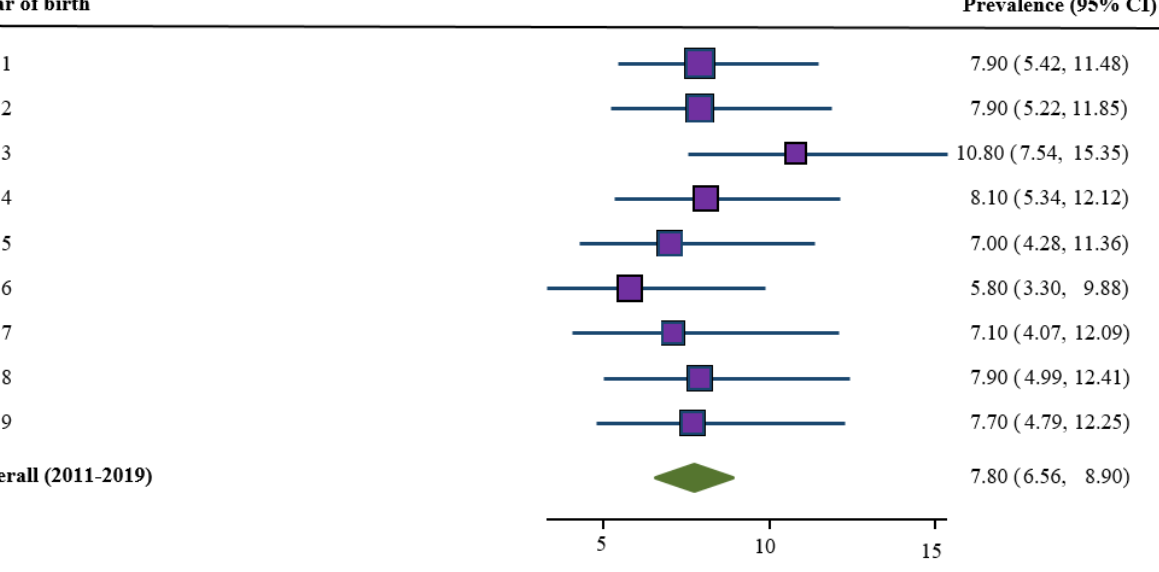
Figure 2. Trends in prevalence of LBW for the period 2011–2019, Southern New South Wales Local Health District (SNSWLHD) ( N = 2099) .